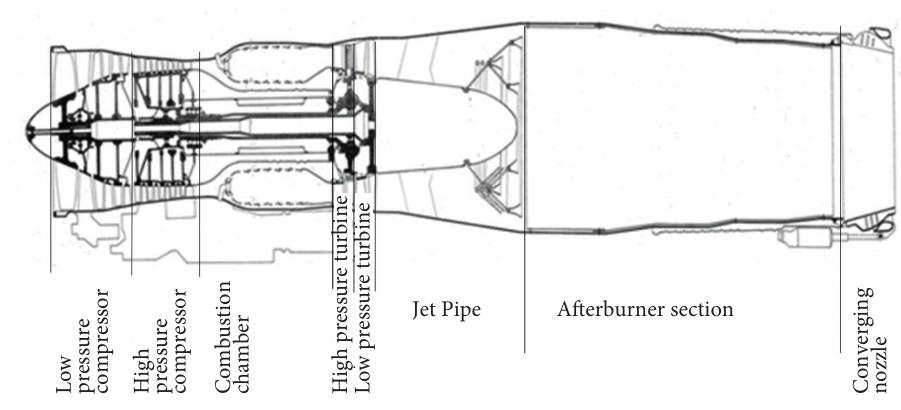
Figure 1. Section view of the turbojet engine showing major turbomachinery